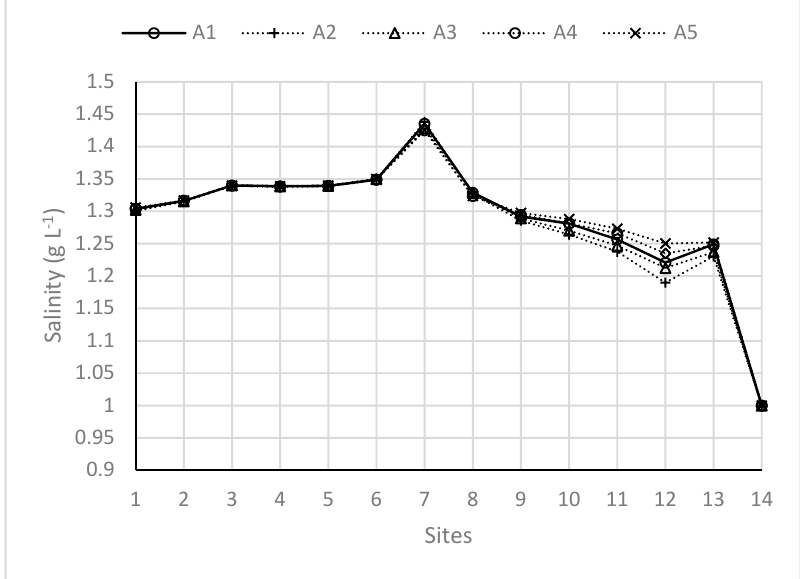
Figure 16. Comparison between the salinity of different sites in experiments A1, A2, A3, A4, and A5.